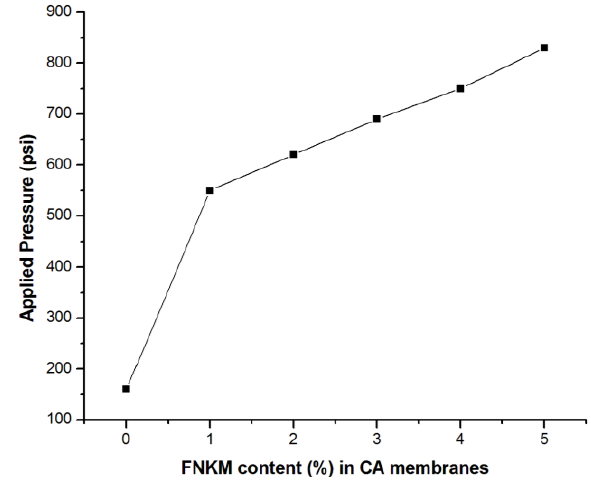
Figure 7. Relationship between FNKM loading content and applied pressure.